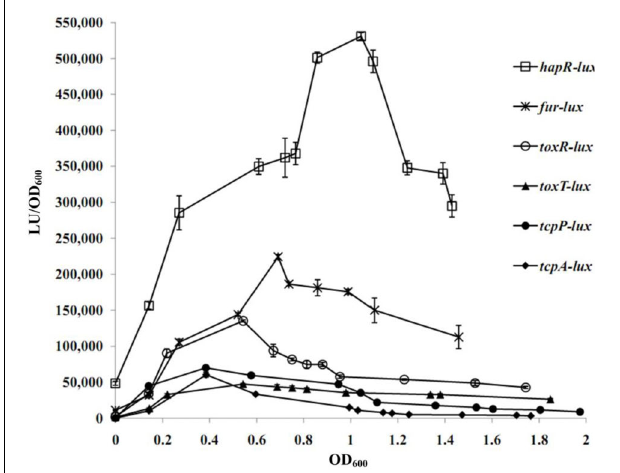
FIGURE 2 | Cell density–dependent expression of target genes. The WT strain was transformed with a recombinant pBBRlux vector that contains a promoter DNA region of the target gene. The bacteria were cultivated in the TCP-induced AKI conditions to determine the luminescence activity under various OD 600